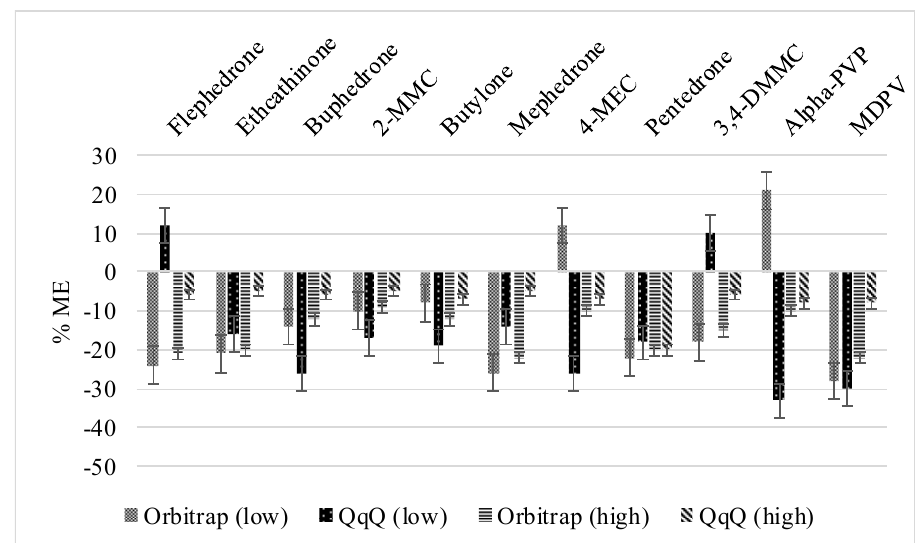
Figure 2. The percentage of matrix effect (%ME) at low (1 ng mL − 1 ) and high (40 ng mL − 1 ) levels of concentrations for Orbitrap and QqQ in the analysis of synthetic cathinones in urine.